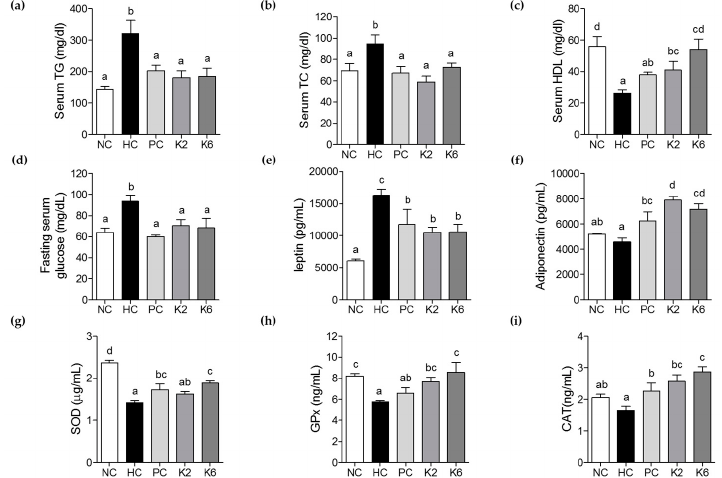
Figure 4. Effects of K2 and K6 on serum biochemical parameters in the rat model of HF/HF-induced NAFLD. ( a ) Serum TG, ( b ) serum TC, ( c ) serum HDL, ( d ) fasting serum glucose, ( e ) leptin, ( f )